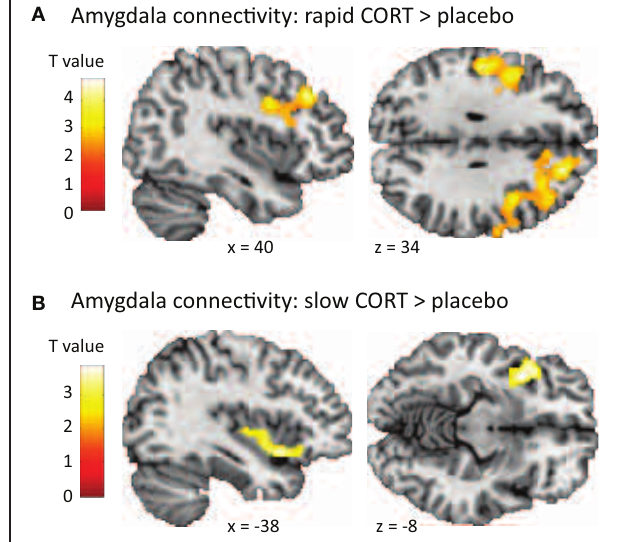
FIGURE 3 | Effects of corticosteroids on amygdala connectivity. (A) The rapid effects of corticosteroids increased the functional connectivity of the amygdala to regions involved in task execution (middle frontal gyrus, precentral gyrus, and postcentral gyrus), potentiating its influence on task execution. (B) The slow effects of corticosteroids disrupted the negative connectivity between the amygdala and insula, attenuating the effects the amygdala can exert on task execution. For visualization purposes the statistical parametric maps are thresholded at p < 0 . 01 uncorrected with a minimal cluster-size of 250